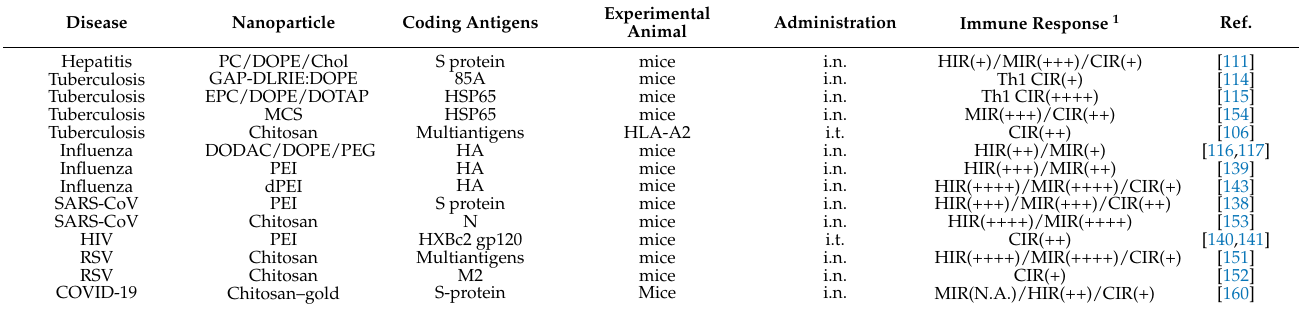
Table 2. Summary of DNA vaccines inoculated via respiratory tract.